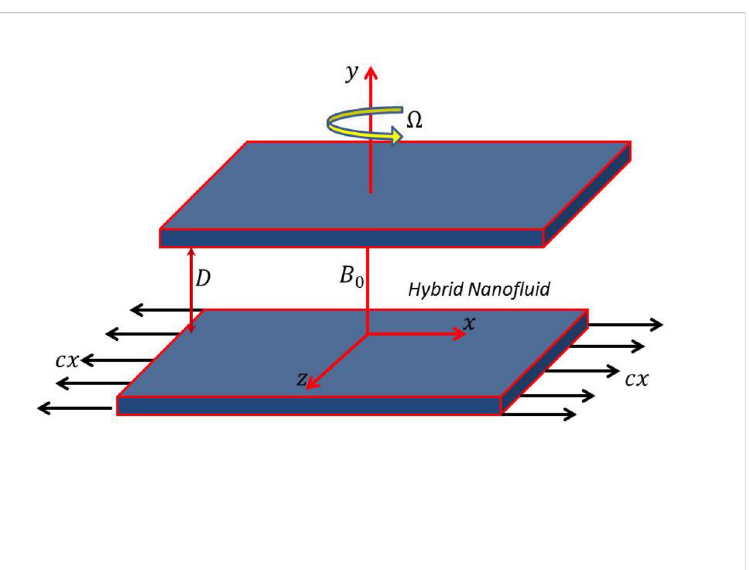
Figure 1. Graphical